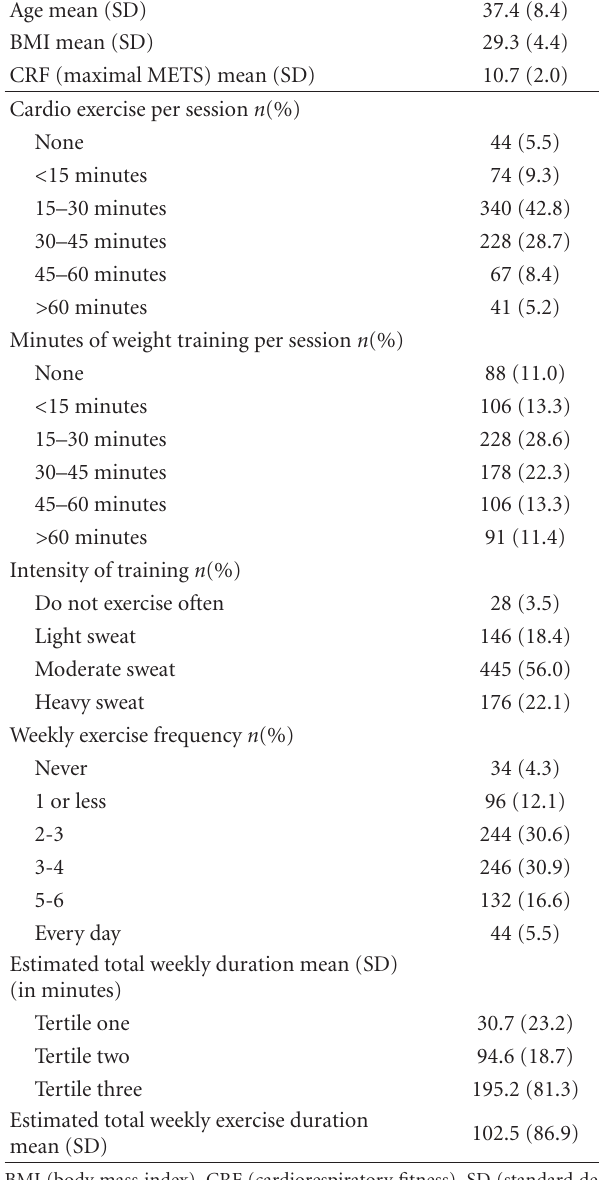
Table 1: Baseline characteristics ( n =